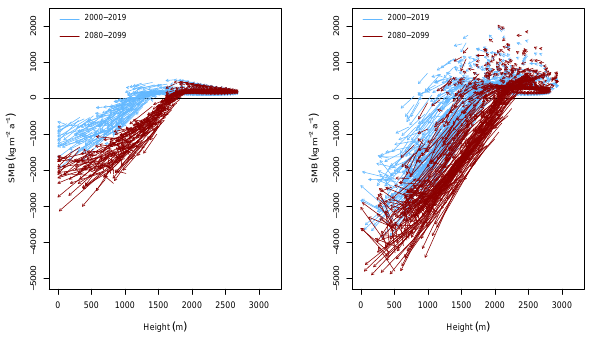
Fig. 4. Changes in SMB when perturbing the height of the MAR ice sheet from the control topography to the NonUn-based topography for grid cells north (left) and south (right) of 77 ◦ N. Arrows point from control to NonUn experiment. Data with height change | ∆ h | < 25m are excluded.